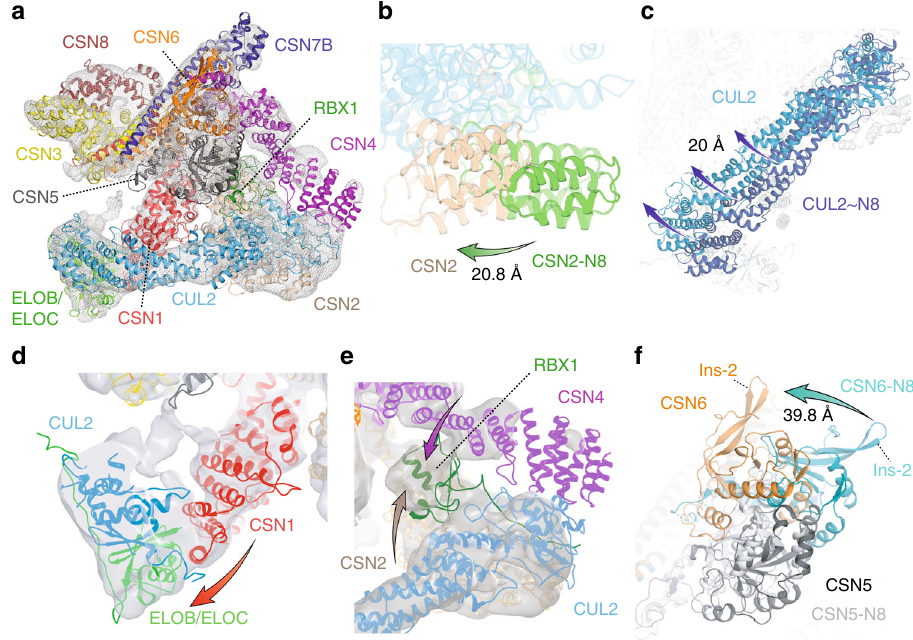
Fig. 2 Structure of the deneddylated CSN – CRL2 complex. a The fi tted density map of deneddylated CSN – CRL2 structure determined by combining cryo-EM and XL-MS. Alignment of the CSN C-terminal helical bundle from the neddylated and deneddylated holocomplexes reveals differences in b CSN2 and c CUL2. d CSN1-ELOB interface established from the rotation of CUL2 in c . e RBX1 is clamped between CSN2 and CSN4. f Conformational changes in CSN6 in the absence of